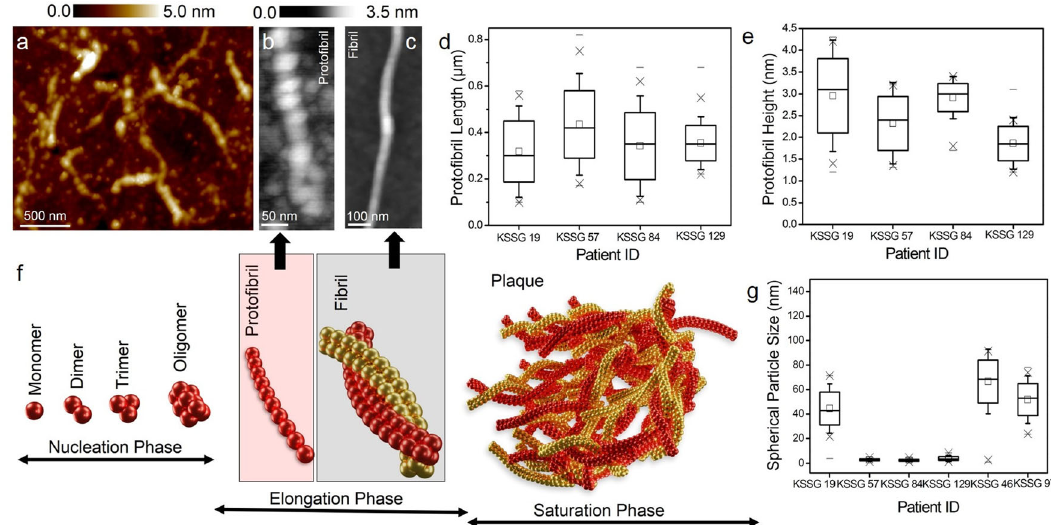
Fig. 3 Quanti fi cation of proto fi brils in CSF from individuals with SCD. a Representative AFM image recorded in CSF from patient KSSG:57 (patient with SCD) showing the presence of both spherical and proto fi brillar aggregates. b AFM topograph of a proto fi bril resolved in CSF from patient KSSG: 19 (SCD) showing distinct nodular morphology. c AFM topograph of a single elongated single fi bril resolved in CSF from patient KSSG: 38 (severe AD) showing a smooth surface topology. d , e Box plots of proto fi brillar length and height distribution values obtained from analysis of AFM images recorded in CSF of patients KSSG:19, 57, 84, and 129. Note: No fi brillar aggregates were detected in the CSF of SCD patients KSSG: 46 and 97. f Schematic of protein aggregates formed along the assembly pathway of pathological proteins implicated in AD. The red and grey shaded regions indicate proto fi bril and fi bril aggregates. g Box plot of spherical particle size distribution in CSF of all SCD patients KSSG:19, 46 57, 84, 97 and 129. The error in the box plots represents the standard deviation of the data sets shown in Fig. 3d, e and g.